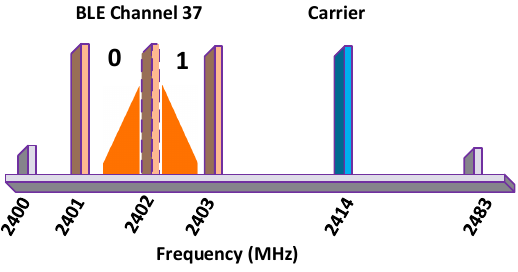
Figure 21. GFSK: frequency plan for creating BLE-compatible backscatter